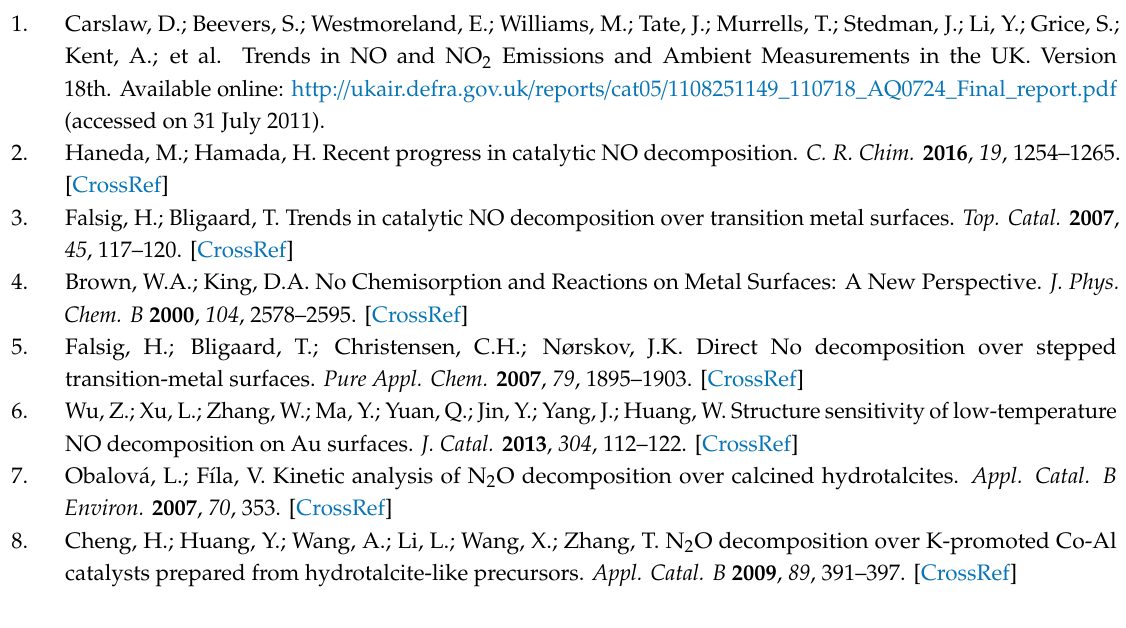
Figure S1: Deconvoluted XPS spectra of the individual elements of the catalysts, Table S1: Binding energies (eV) of core electron levels (adjusted to C 1s = 284.8 eV), Table S2: Surface concentrations of metals determined by XPS